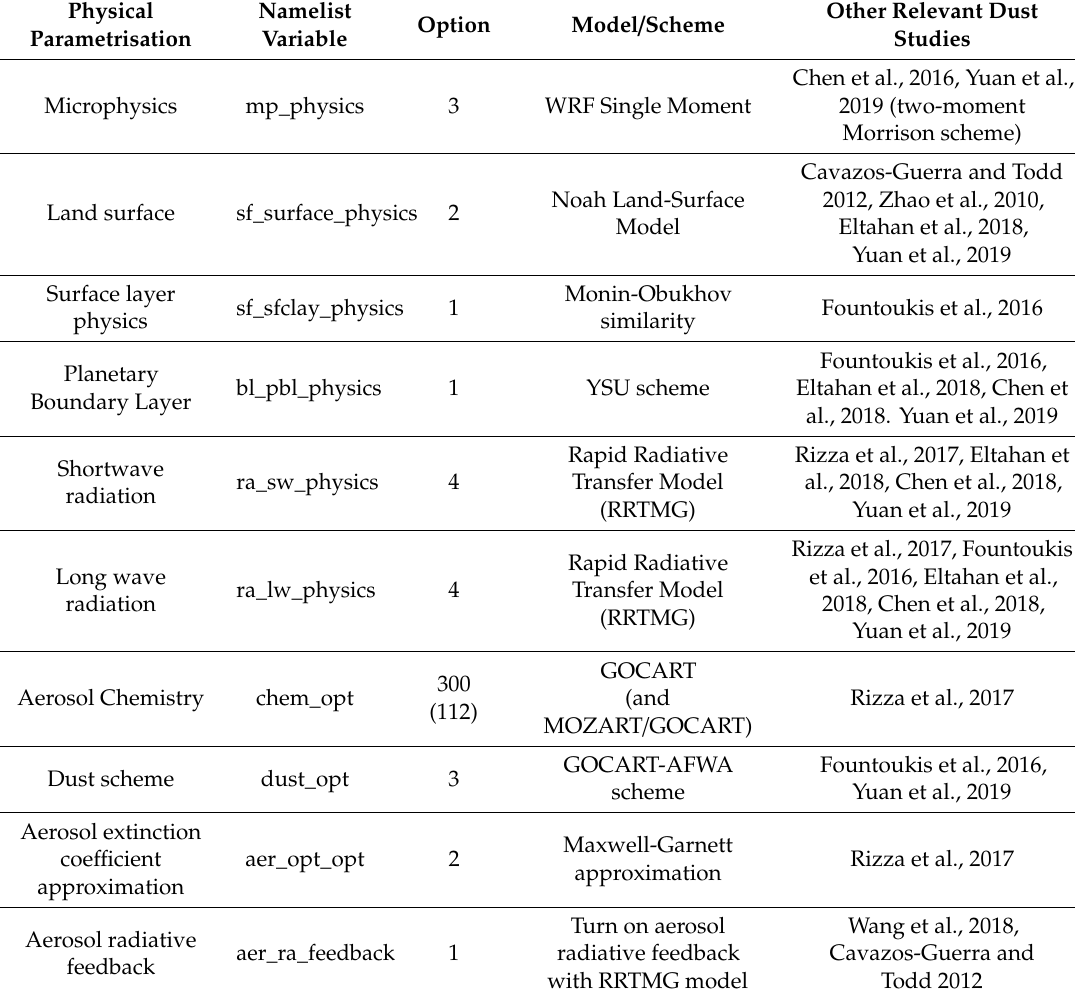
Table 1. Namelist setting in WRF-Chem